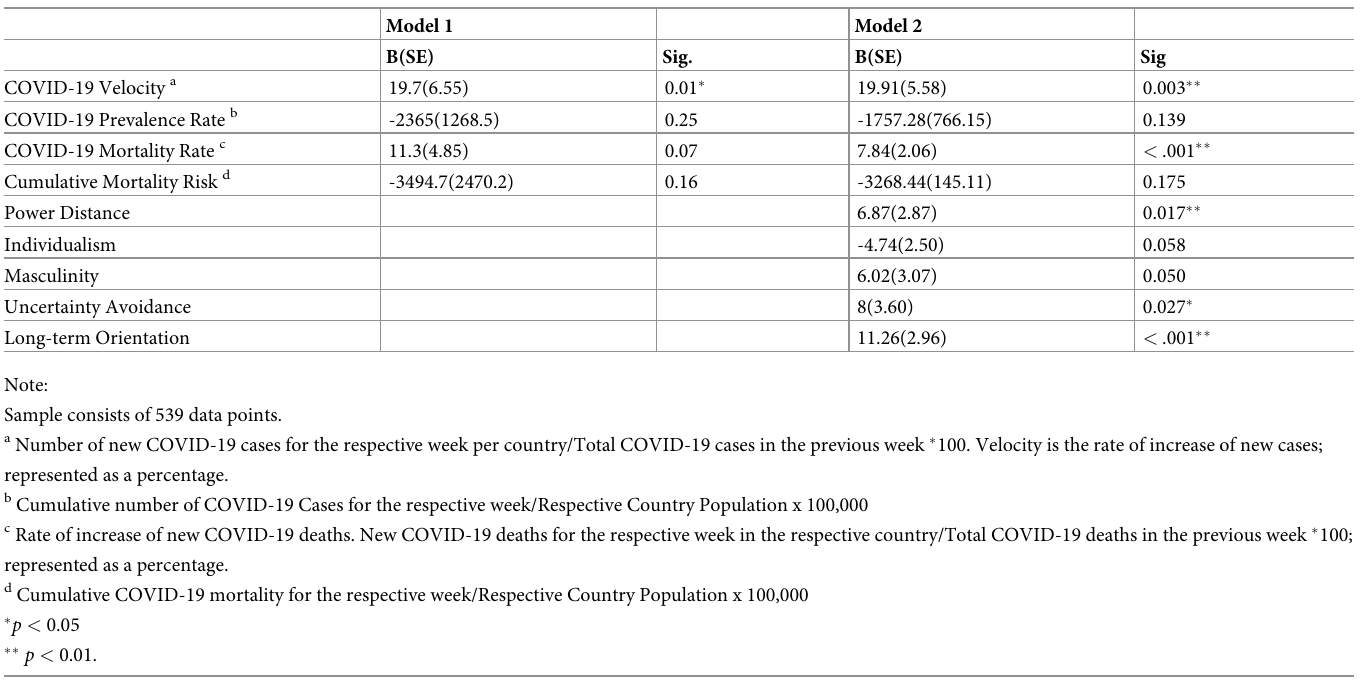
Table 1. Mixed-effects regression models predicting media attention towards